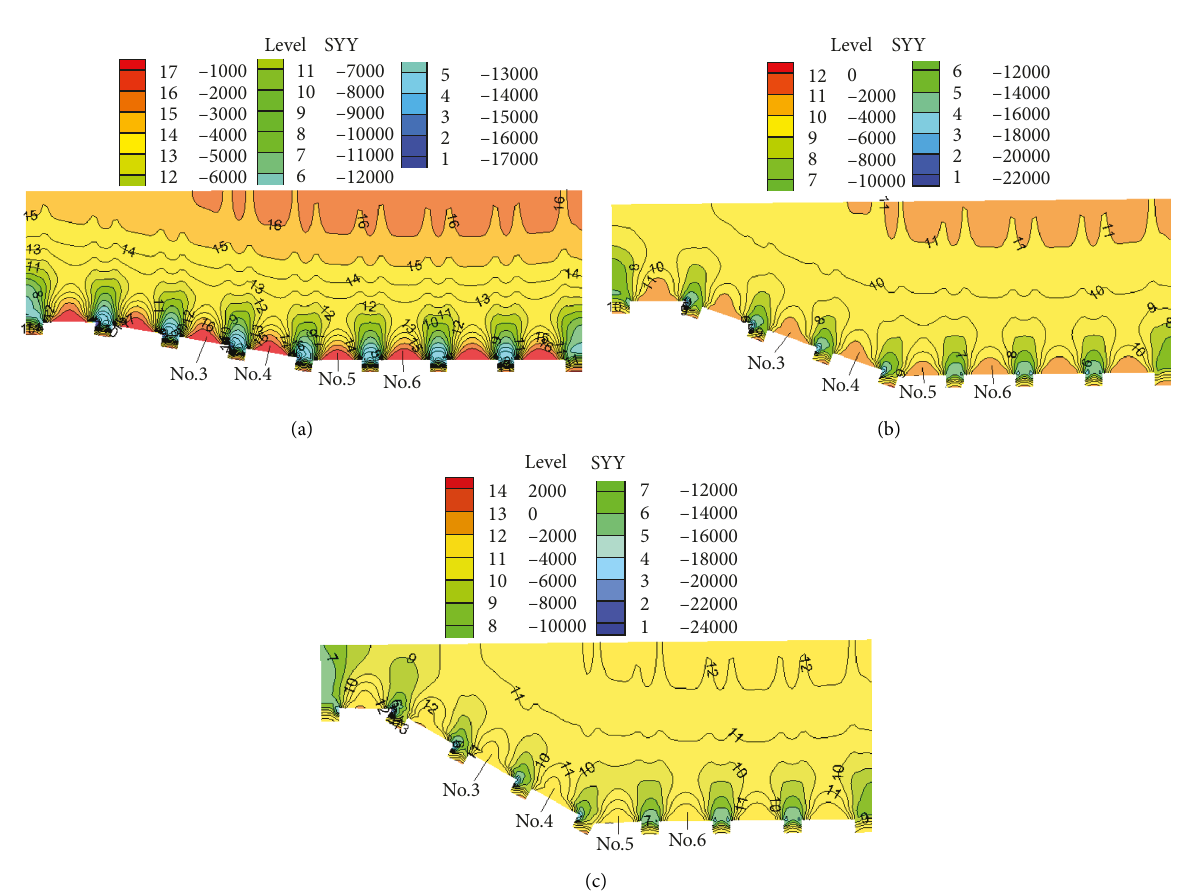
Figure 10: Comparisons among principal stress isoline maps in the Y direction, (a) 10 ° polyline pile arrangement, (b) 20 ° polyline pile arrangement, and (c) 30 ° polyline pile arrangement.